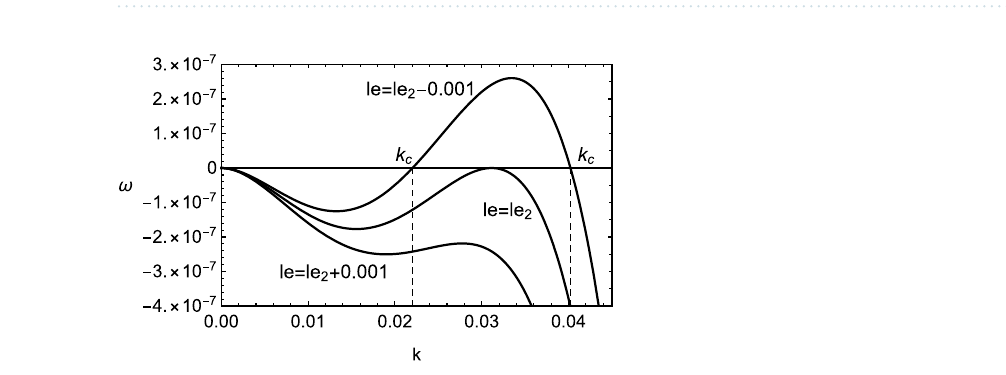
Figure 5. Growth rate ω v.s. wavenumber k for several values of le , with β 0.0538, 0.175 . 4.327 and k case, le 2 c ≈ ≈ −